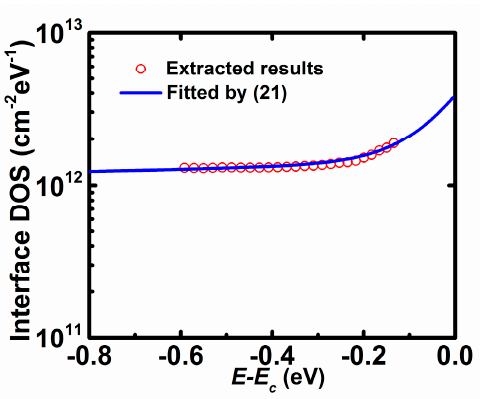
Figure 6. Extracted interface density of states (DOS) as a function of E − E C from the proposed method (symbols) and results fitted by (21) (solid lines).